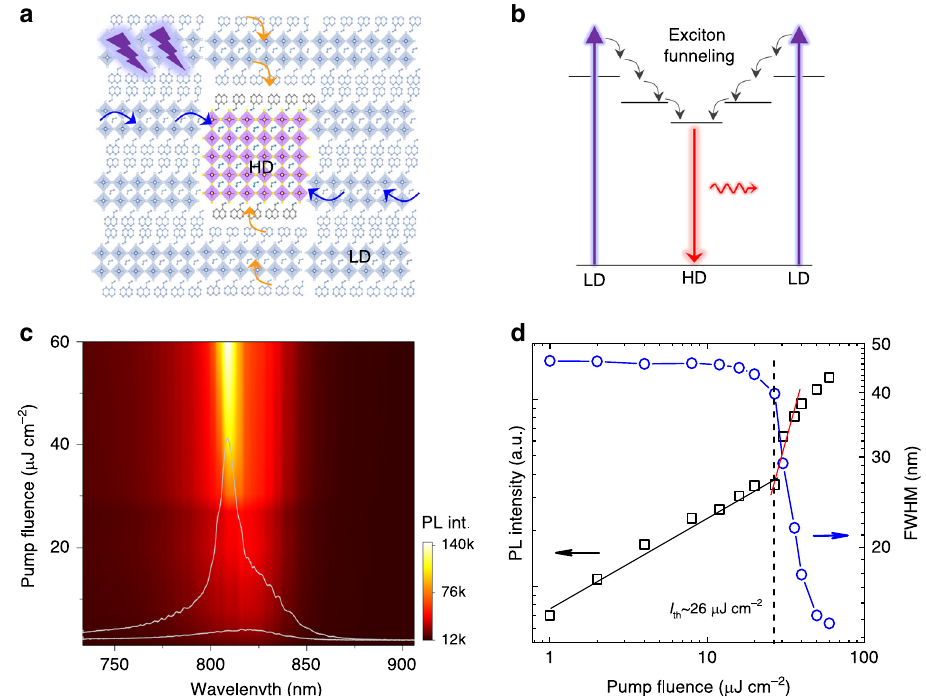
Fig. 1 Stimulated emission from perovskite multiple quantum wells (MQWs). a Schematic illustration of the localization of photogenerated charge carriers from the surrounding low-dimensional (LD, dominated by n = 2 QWs) to high-dimensional (HD, n ≥ 5) perovskite QWs. The blue and orange arrows indicate the lateral and vertical charge transfer, respectively. b Schematic energy level diagram shows the photogenerated excitons funneling process. c 2D pseudocolor plot of the photoluminescence (PL) intensities of perovskite MQWs with pump fl uence from 1 to 60 µ J cm -2 (under 400 nm, 50 fs, 1 kHz fs laser excitation). The broad and sharp curves represent the PL spectra below and above the stimulated emission threshold, respectively. d Log – log plot of the integrated PL intensities and the full width at half maximum (FWHM) as a function of pump fl uence. The black and red solid lines are linear fi t slopes of PL intensities below and above the stimulated emission